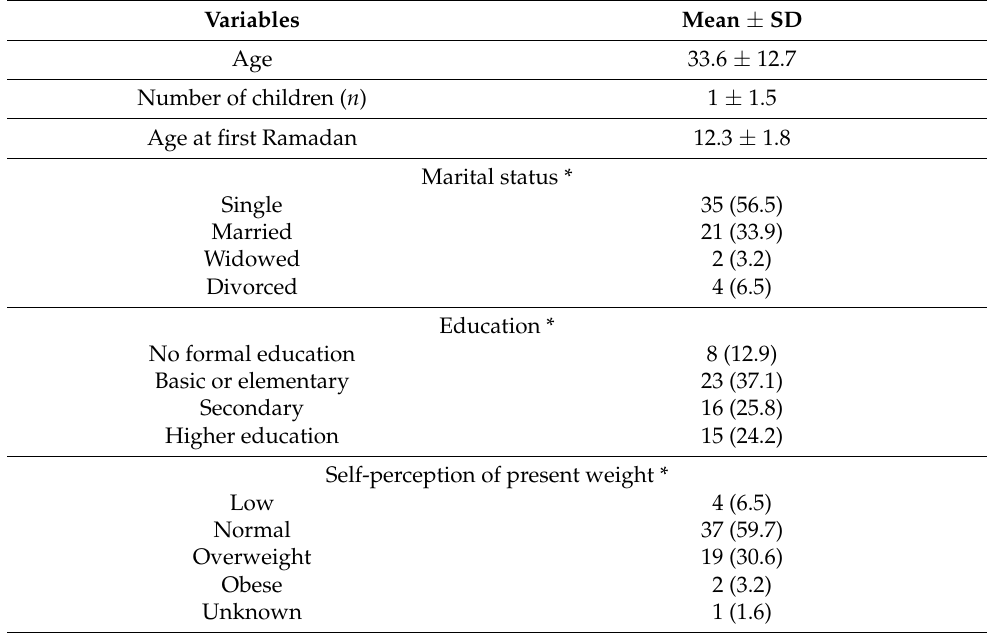
Table 1. Sociodemographic